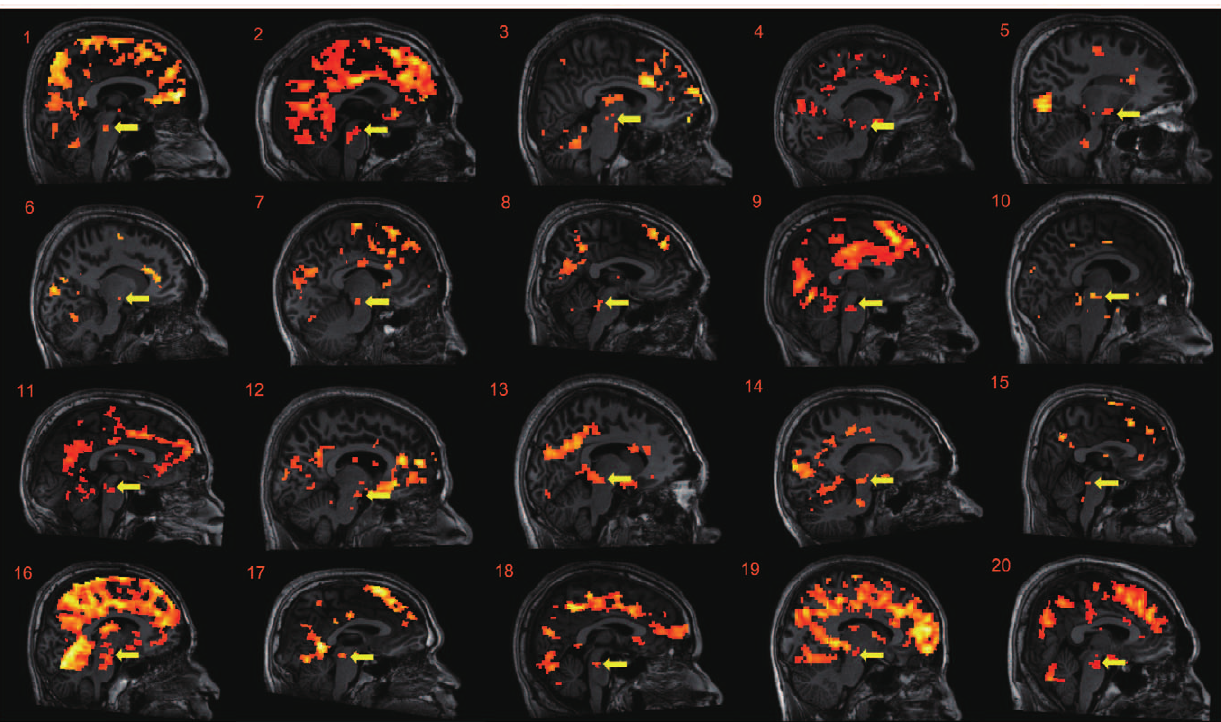
Figure 4. Individual analyses. Deactivation in the midbrain reflecting compensatory effort (i.e., [Pre H – PostH] – [PreE – PostE]) was re-analyzed on an individual basis within the subject’s native space, and each anatomical image was overlain on the mid-sagittal section. All voxels were significant at a statistical threshold of p , 0.05, uncorrected.